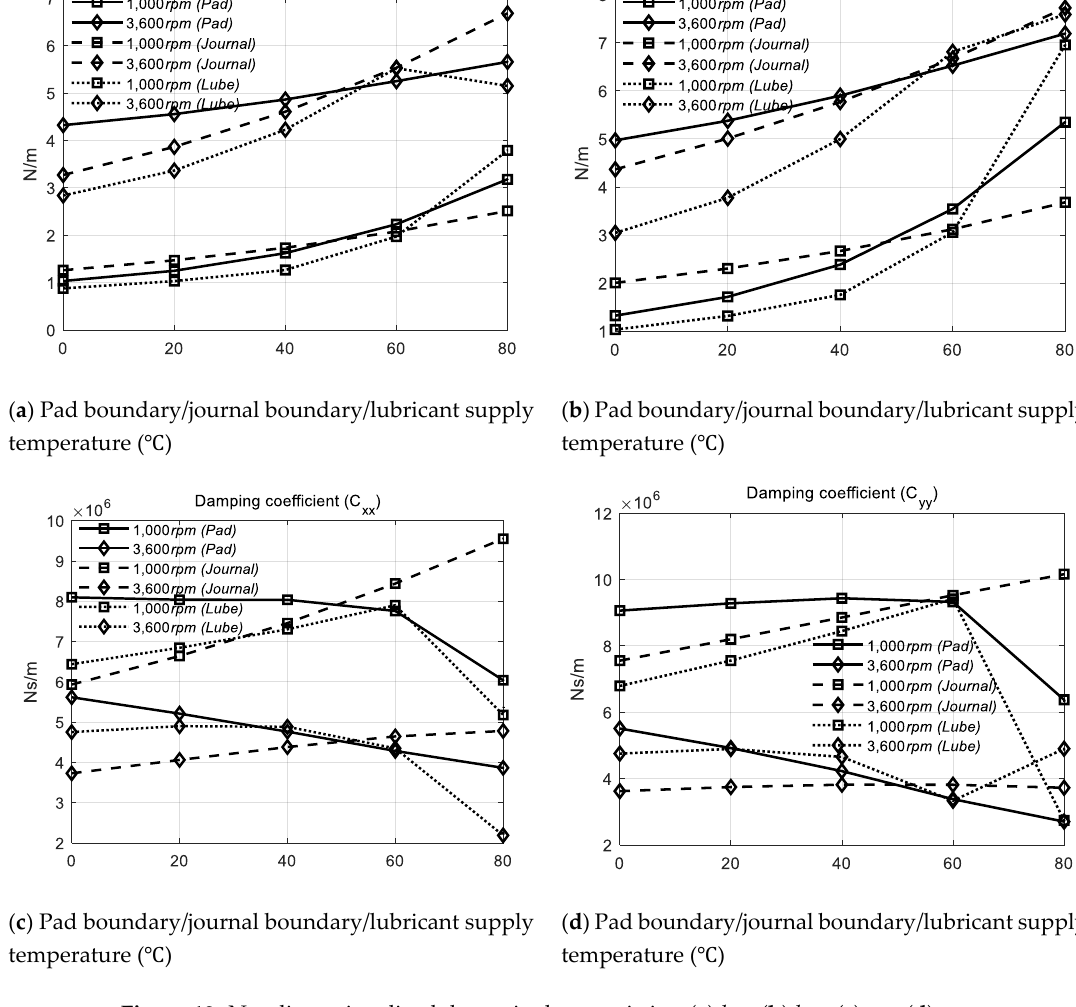
Figure 10. Nondimensionalized dynamic characteristics: ( a ) 𝑘 𝑥𝑥 ; ( b ) 𝑘 𝑦𝑦 ; ( c ) 𝑐 𝑥𝑥 ; ( d ) 𝑐 𝑦𝑦 .